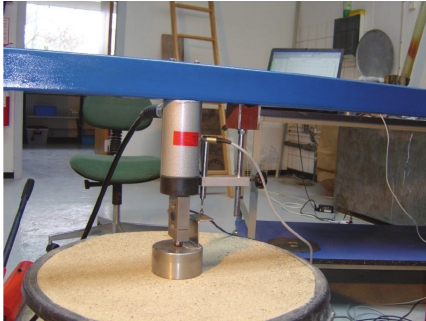
Figure 7: Load test arrangement.